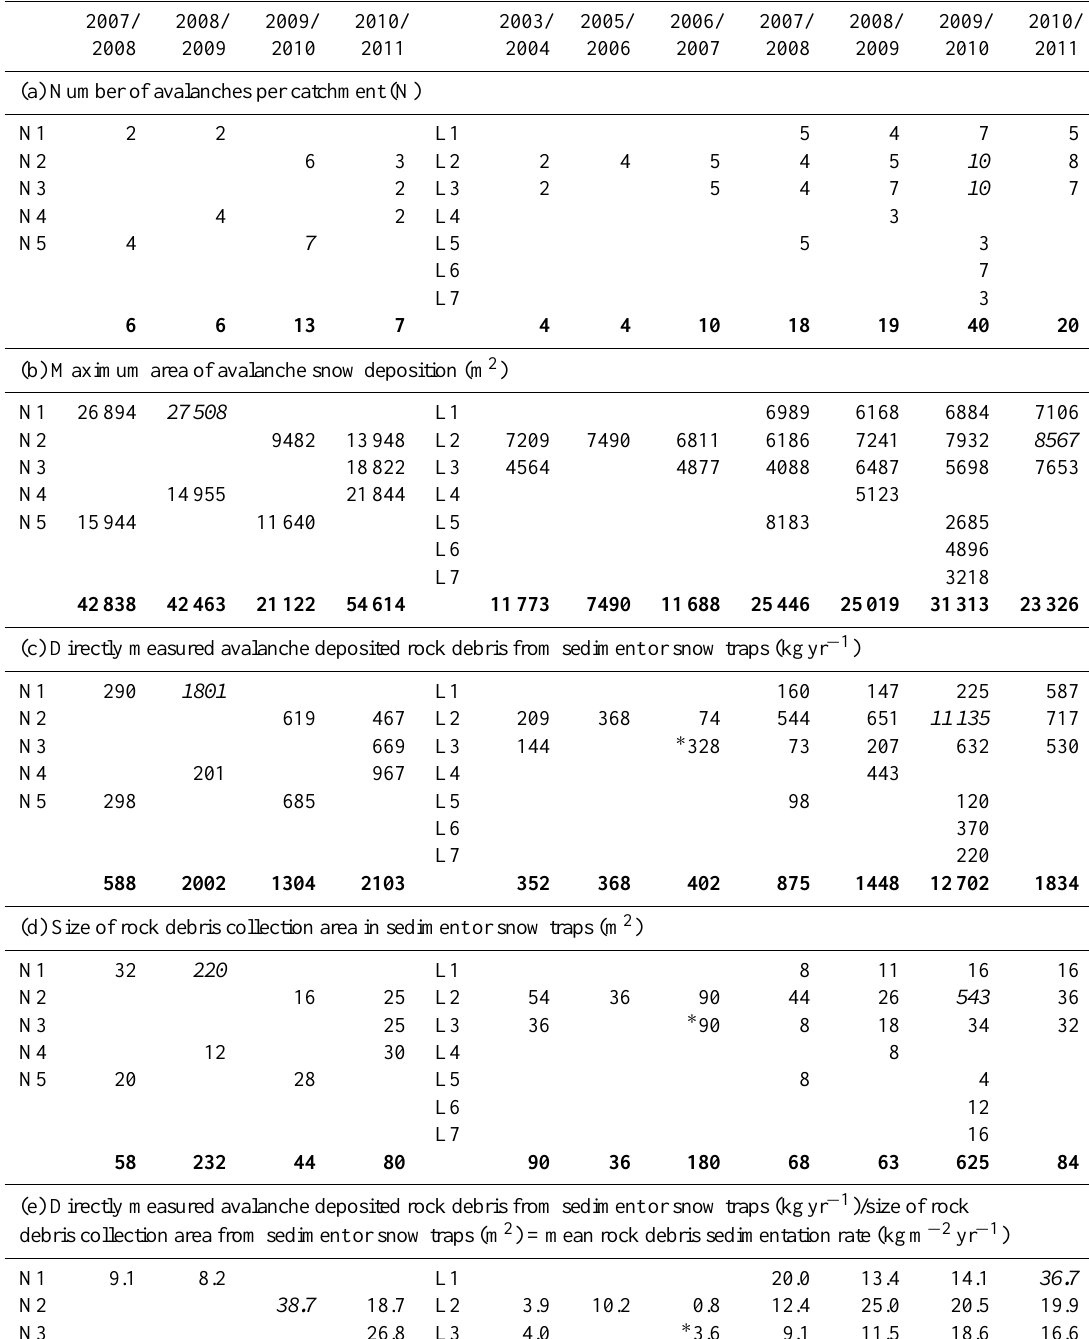
Table 1. All calculations to obtain avalanche sedimentation (kgyr − 1 ) for each catchment at the Nybyen (N1–N5) and Larsbreen (L1–L7) slope systems. The annual averages or sums for Nybyen and Larsbreen are given in bold. The highest values and rates for each calculation step are given in italic. The values and rates marked with an asterisk are from 2yr of observations. Avalanche sedimentation values (kgyr − 1 ) from Larsbreen, which are underlined, are only calculated from permanent sediment